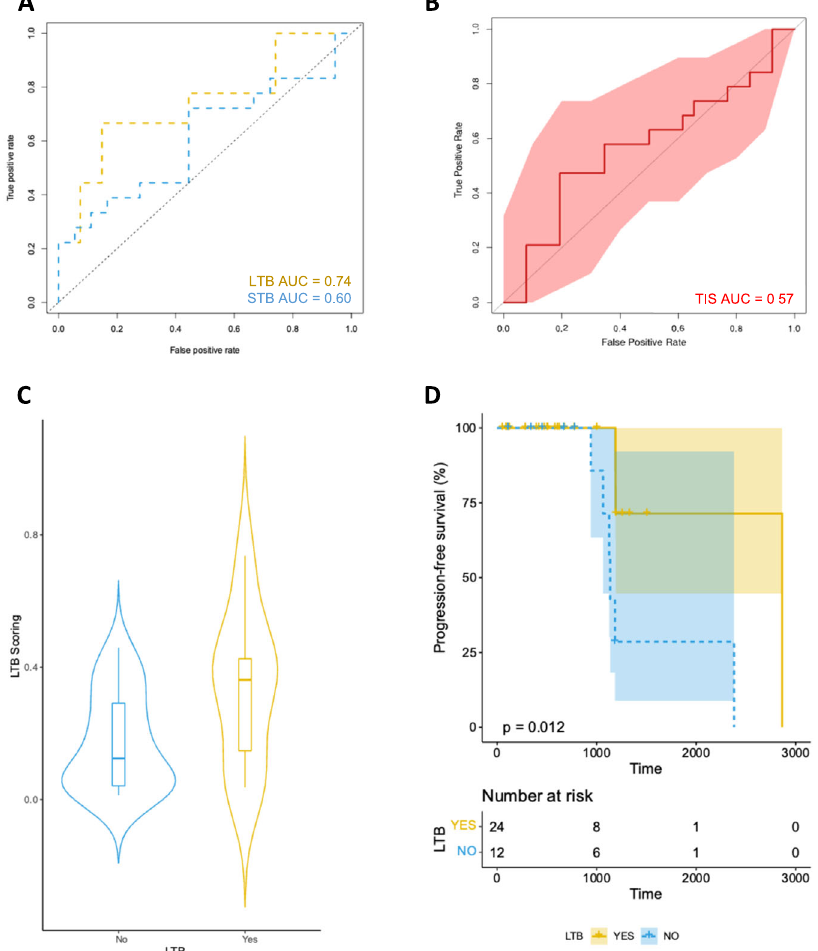
Fig. 5 Validation of the 12-gene signature that predicts LTB from programmed cell death protein 1-based immunotherapies in patients with advanced or metastatic melanoma. A Receiver operating characteristic curves for LTB and STB signatures in the validation set. B Receiver operating characteristic curves for the TIS signature in the validation set. C Violin plot showing the distribution of scores according to LTB outcome in the validation set. D Kaplan – Meier curve for PFS for patients ranked high according to the 12-gene LTB signature score in the validation set. For the validation set the low subgroup has a minimum score of 0.0001396, 1st quartile of 0.018, median of 0.09, mean of 0.12, 3rd quartile of 0.18 and maximum score of 0.39; the high subgroup has a minimum score of 0.1880, 1st quartile of 0.32, median of 0.7, mean of 0.57, 3rd quartile of 0.74 and maximum score of 0.84. The error bars correspond to the 95% con fi dence intervals. LTB long-term bene fi t, STB short-term bene fi t, AUC area under the curve, PFS progression-free